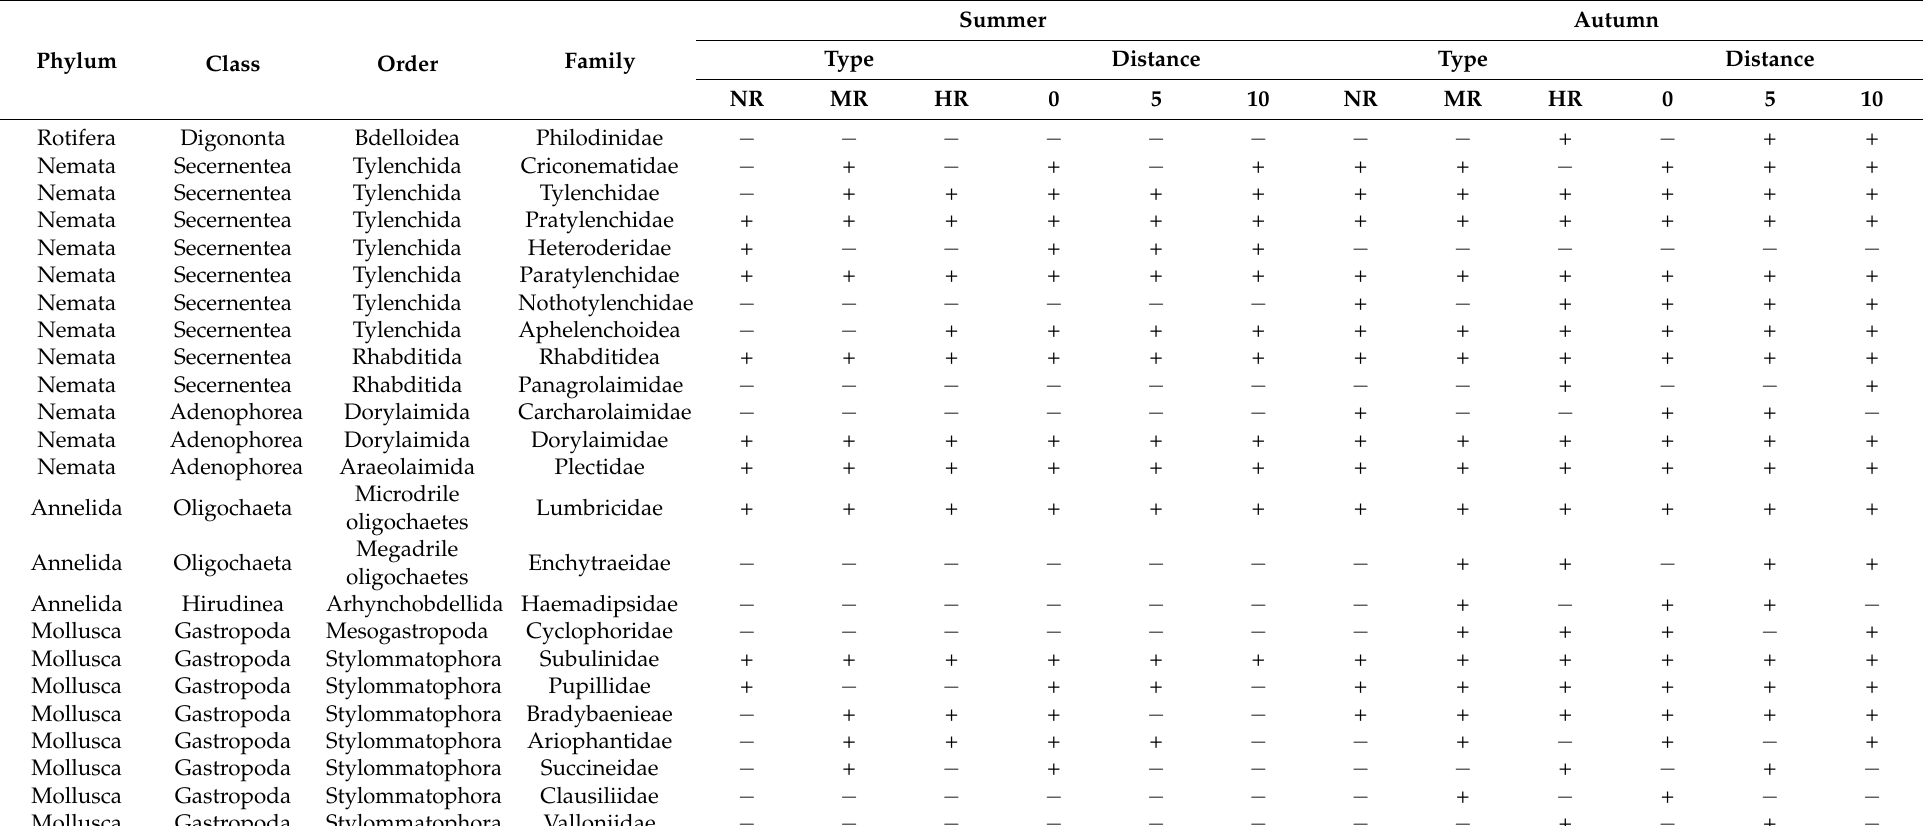
Table A5. Compositions of soil fauna communities for three revetment types and three